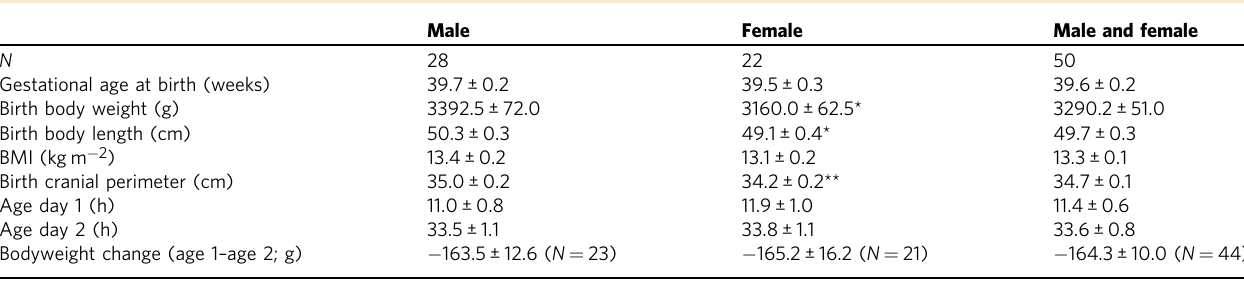
Table 1 Anthropometric parameters of